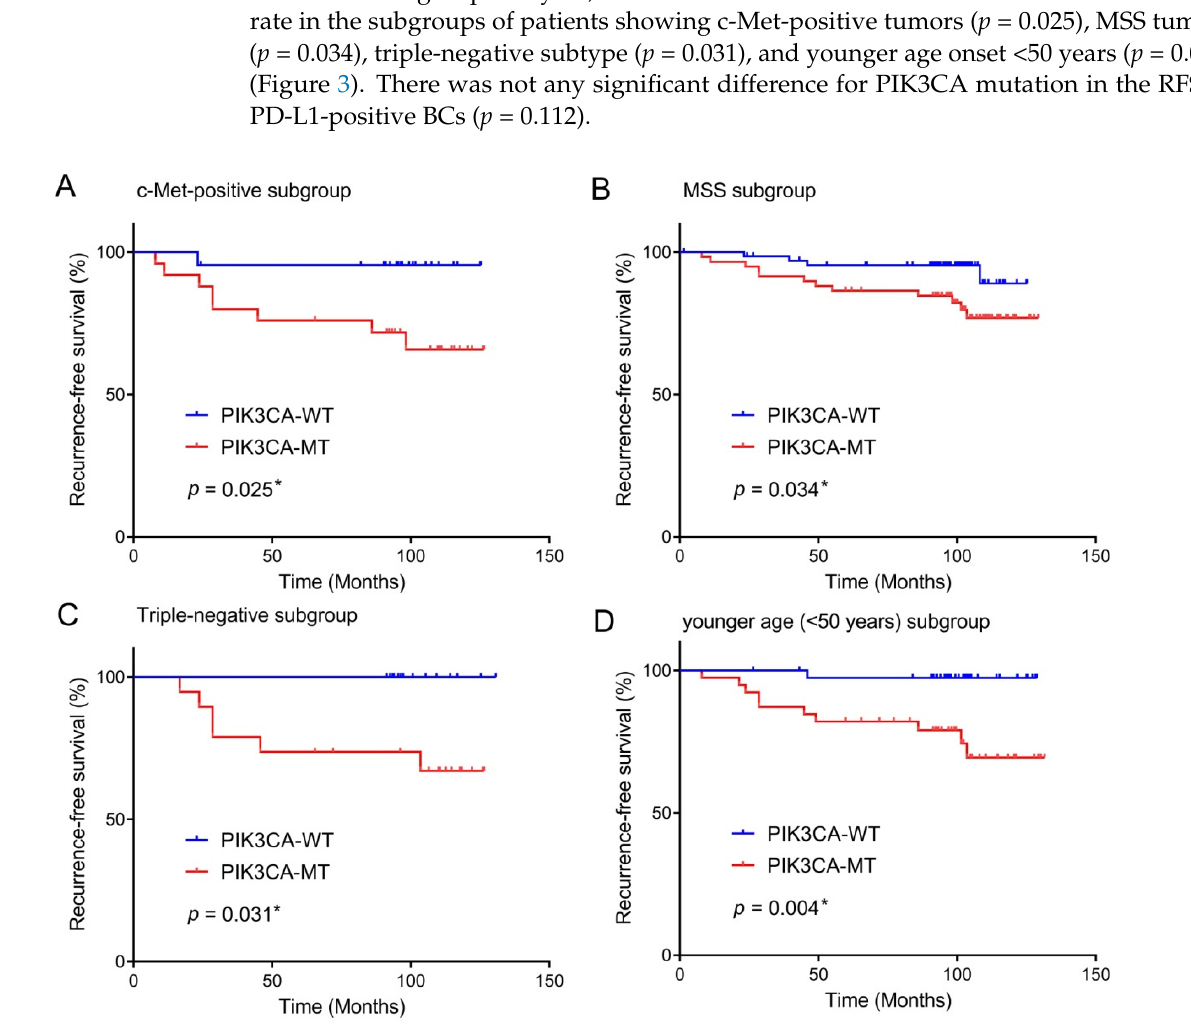
Figure 3. Prognostic impact of PIK3CA mutation in breast cancers according to subgroups. The presence of PIK3CA mutation predicts unfavorable recurrence-free survival of patients with c-Met-positive tumors ( A ), MSS tumors ( B ), triple-negative subtype ( C ), age younger than 50 years old ( D ). * statistically significant, p value < 0.05.